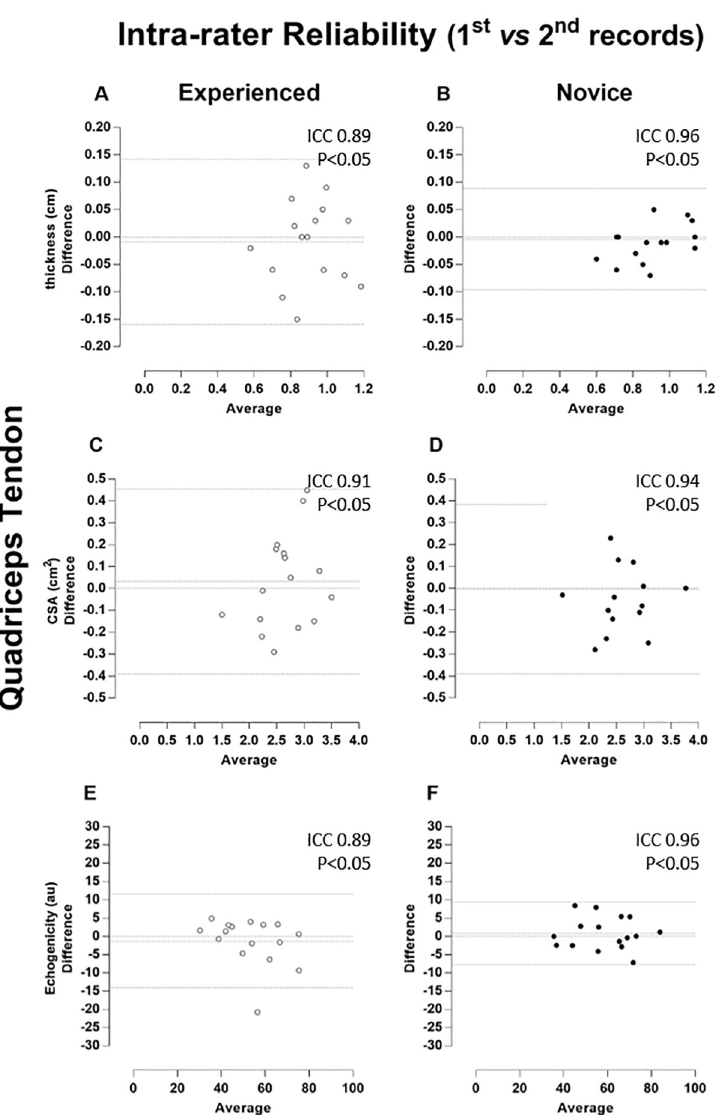
Fig 3. Quadriceps tendon–Intra-rater Reliability (1 st vs 2 nd records). Bland-Altman plots of the intra-rater comparison between first (1 st ) and second (2 nd ) repeated records of the thickness (A and B), cross-sectional area (CSA, C and D), and echogenicity (E and F) taken on the quadriceps tendon. The images taken by the experienced rater are in the left column (A, C, and E) and plotted by white circles, whereas those taken by the novice rater are in the right column (B, D, and F) and plotted by black circles. Besides the zero lines, the bias line and random error lines showing the 95% limits of agreement are represented by dashed